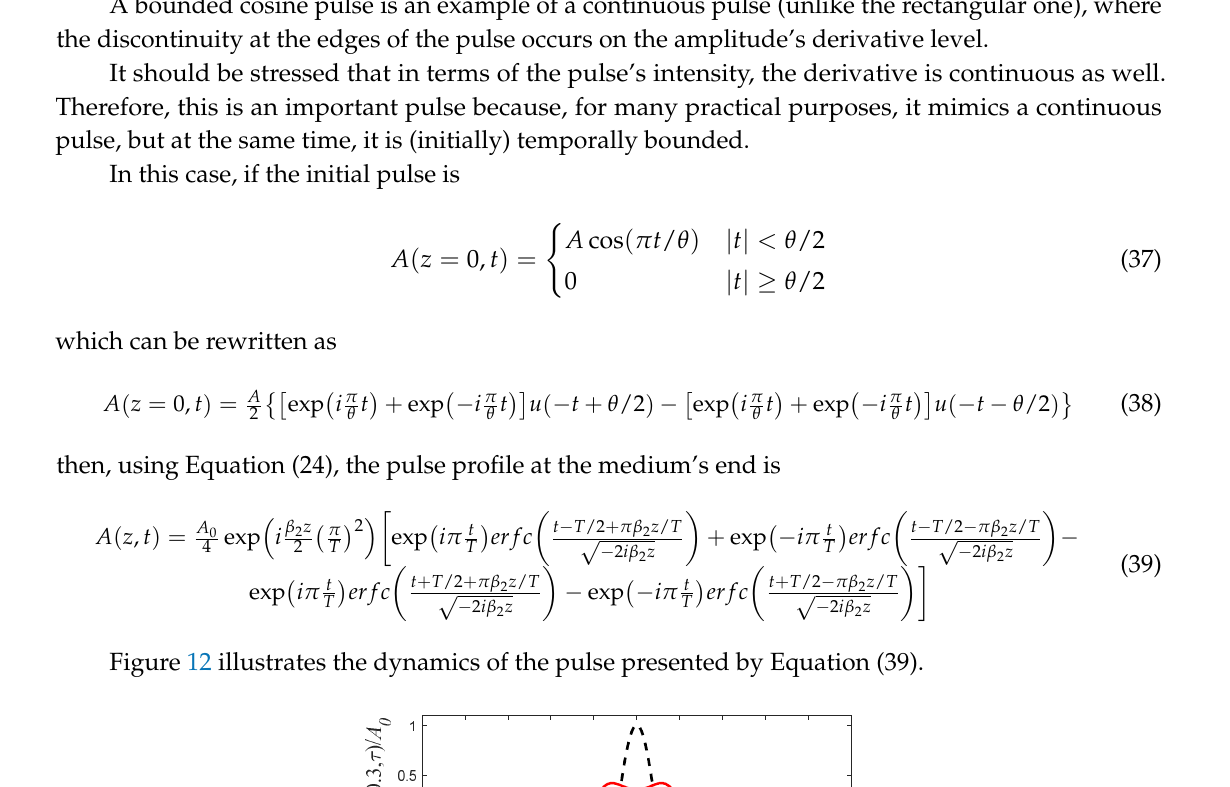
Figure 11. Same as Figure 2, but for the intensity (